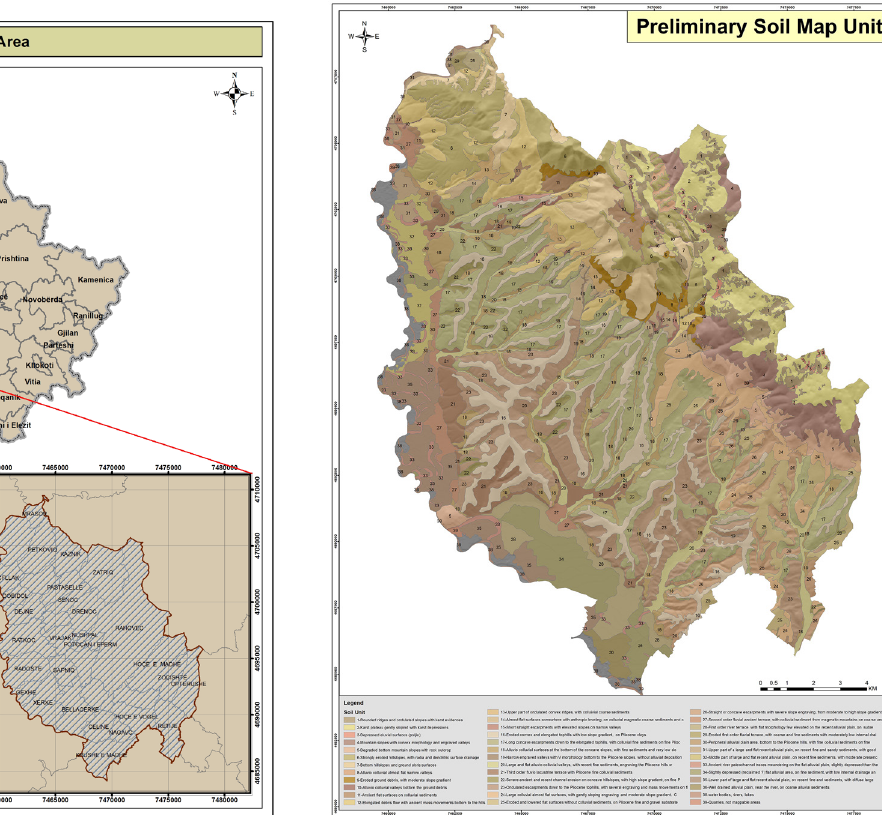
Figure 1. Study area Figure 2. A preliminary land unit